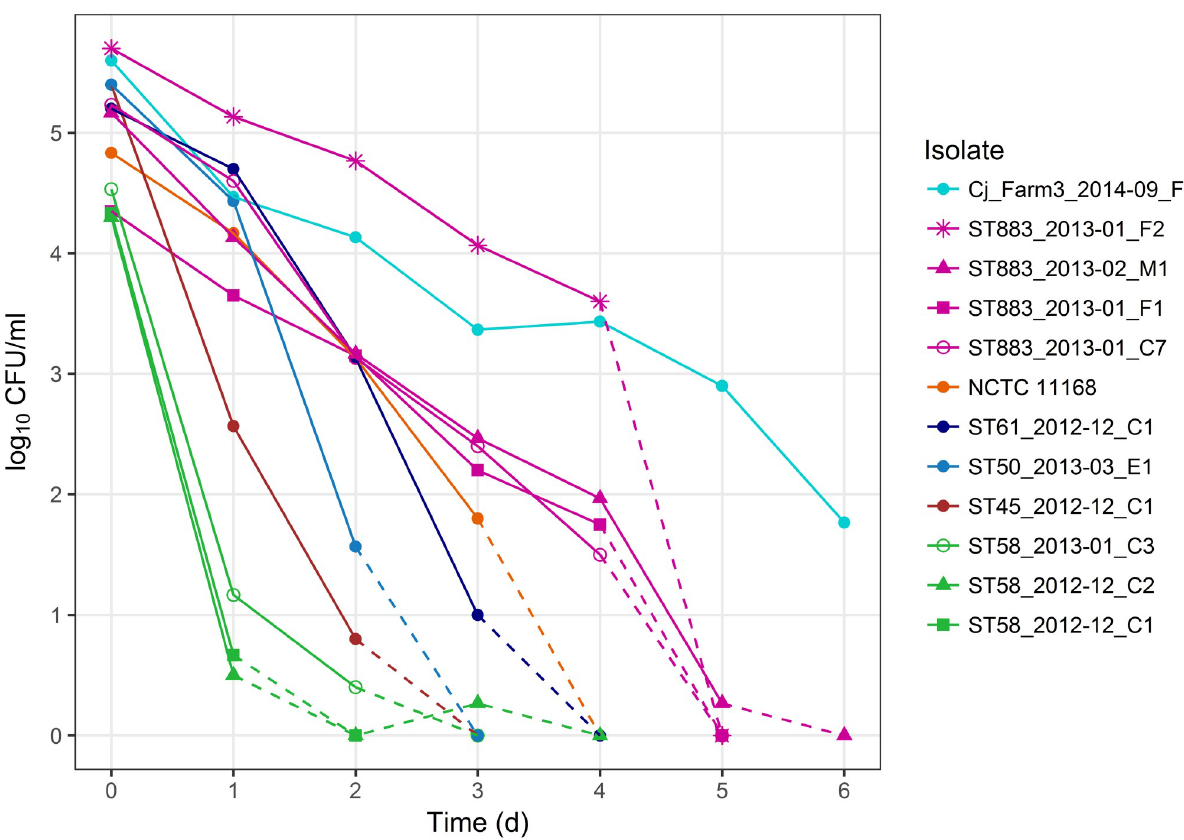
Fig 2. Survival of C . jejuni farm isolates in refrigerated raw milk. Mean colony counts of three experiments are shown at time points 0 d (maximum standard error of the mean ± 0.6), 1 d ( ± 0.7), 2 d ( ± 1.0), 3 d ( ± 0.7), 4 d ( ± 1.0), 5 d ( ± 0.3), and 6 d ( ± 0.1). Dashed lines indicate the decrease of C . jejuni counts below the quantification limit (0 log 10 CFU/ml): between 0 and 3 d (ST-58 isolates), between 2 and 3 d (ST-50 and ST-45 isolates), between 3 and 4 d (ST-61 isolate and control strain NCTC 11168), and between 4 and 6 d (ST-883 isolates). ST-883 isolate (Cj_Farm3_2014–09_F1) from another dairy farm [11] could be quantified at every time point for 6 d. Summary statistics of the data are presented in Table A in S1 Datasets.